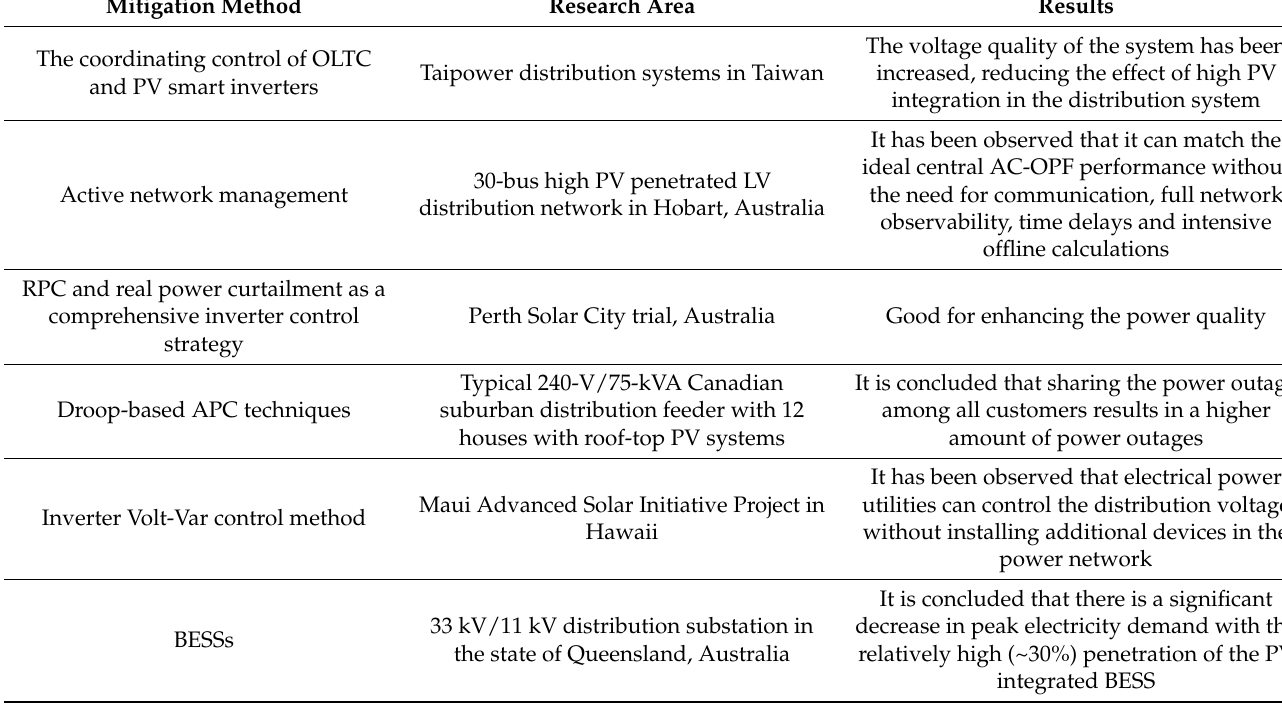
Table 6. Voltage Control